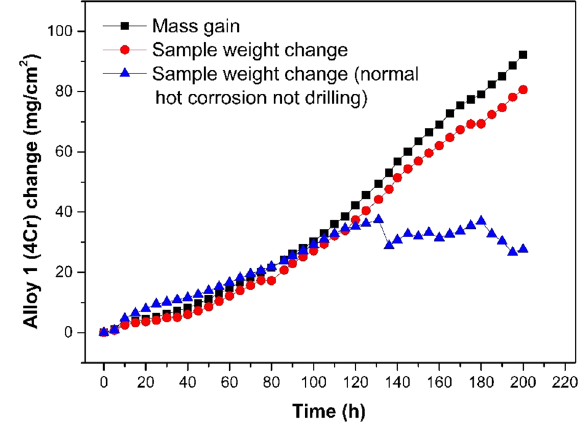
Fig. 4 Weight change curve. The drilling normal hot-corroded kinetic curves of the samples at 900